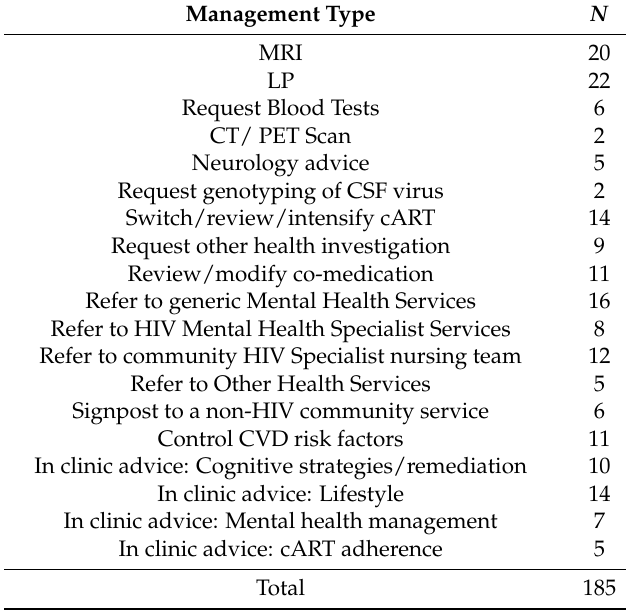
Table 3. N and type of intervention administered by the